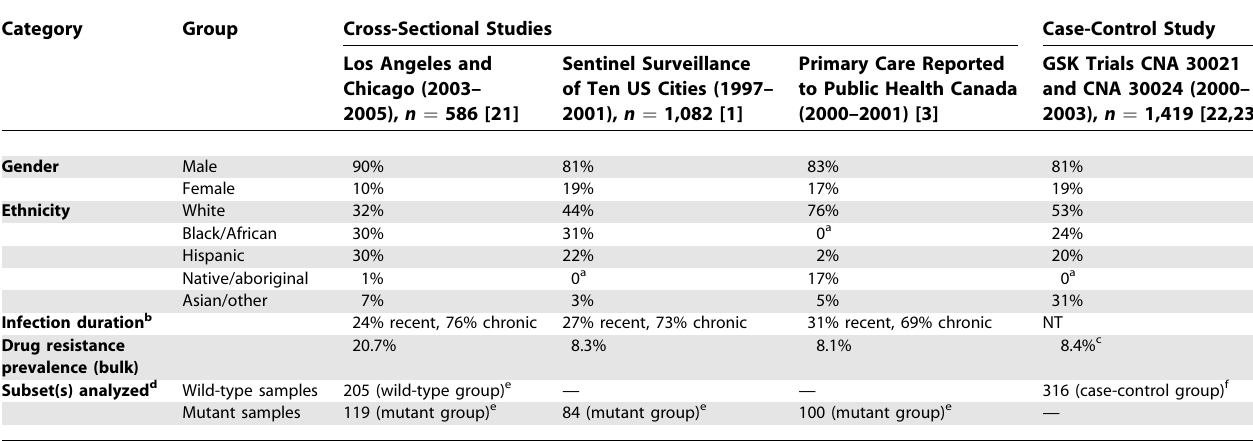
Table 1. Characteristics and Conventional Drug Resistance Genotypes of Newly Diagnosed Drug-Naı¨ve Populations Sampled for Sensitive Real-Time PCR Drug Resistance Testing in the Cross-Sectional and Case-Control Studies